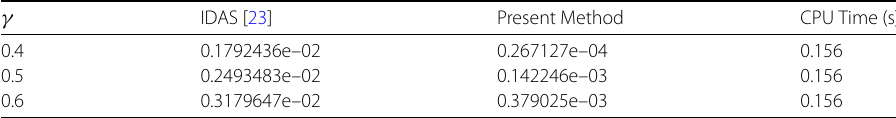
for Example 3 32